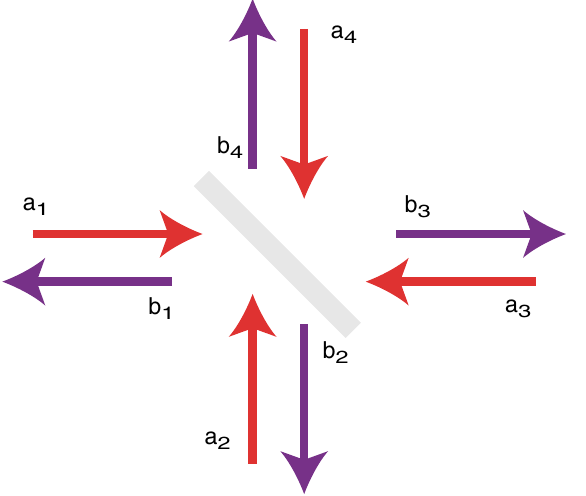
FIG. 9. (Color) The a ’s and b ’s are the complex amplitudes of the incoming and outgoing electric fields,